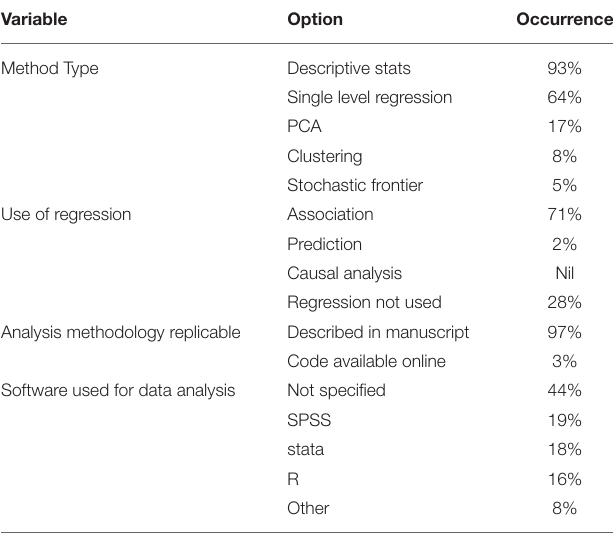
TABLE 5 | Analysis methods, replicability and software used.